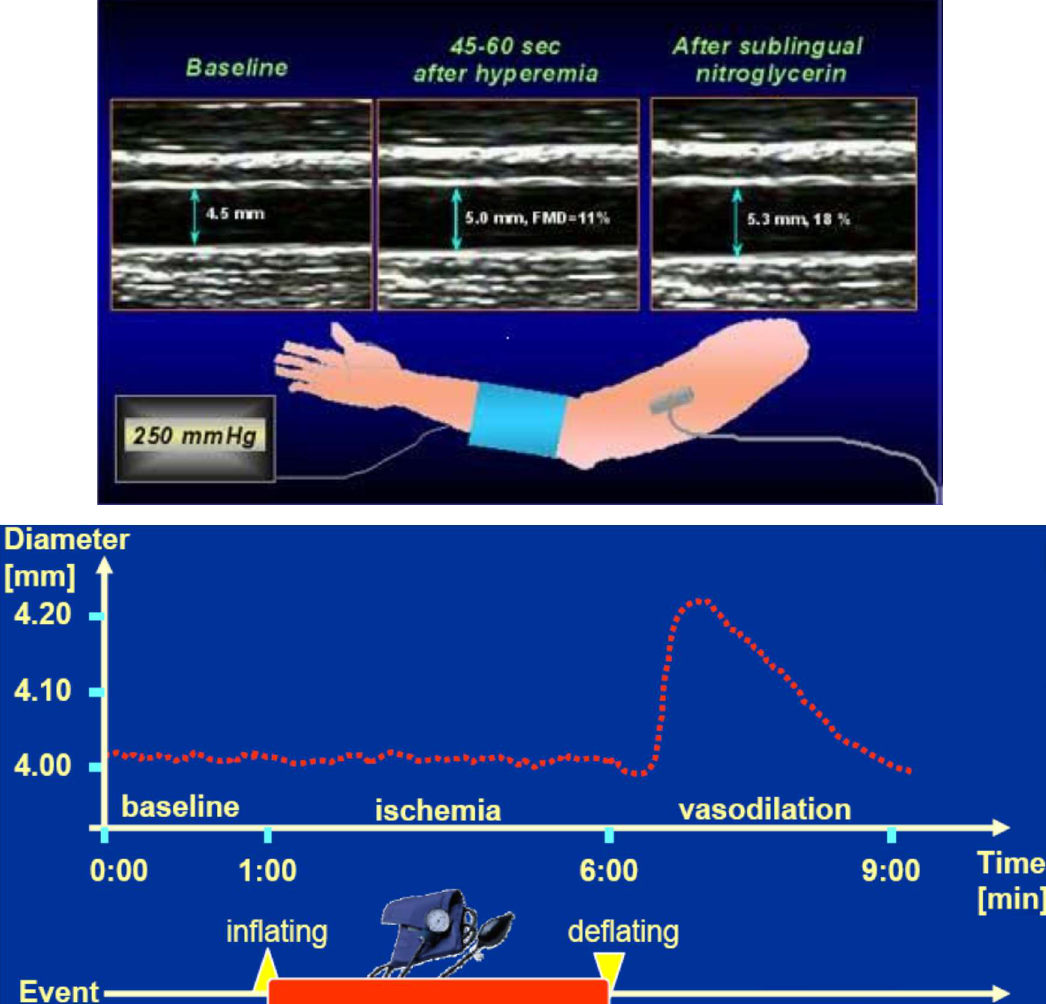
Figure 1. Illustration of the method to assess flow-mediated dilation (FMD). Brachial artery diameter is measured at baseline and during hyperemia consequent to 5-min forearm ischemia; FMD is calculated as the percent increase of the artery diameter during hyperemia compared to baseline.